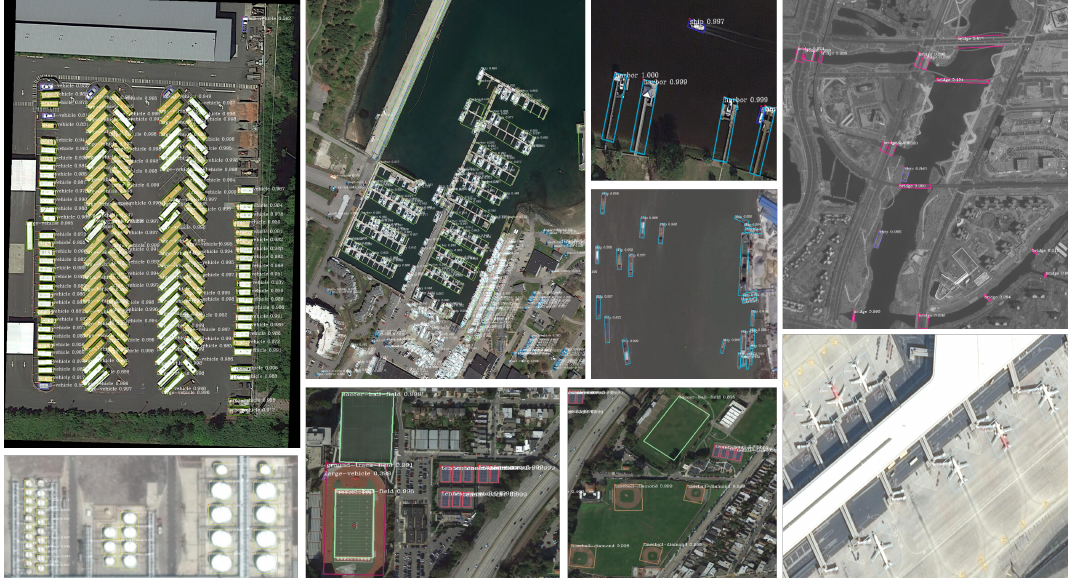
Figure 16. Visualization of the GLS-Net results in the DOTA test